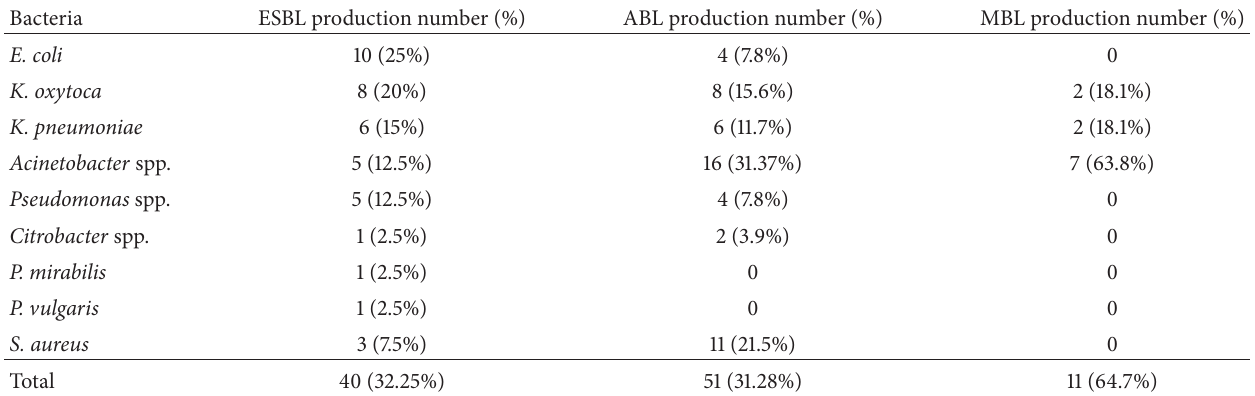
Table 5: ESBL versus ABL versus MBL producing